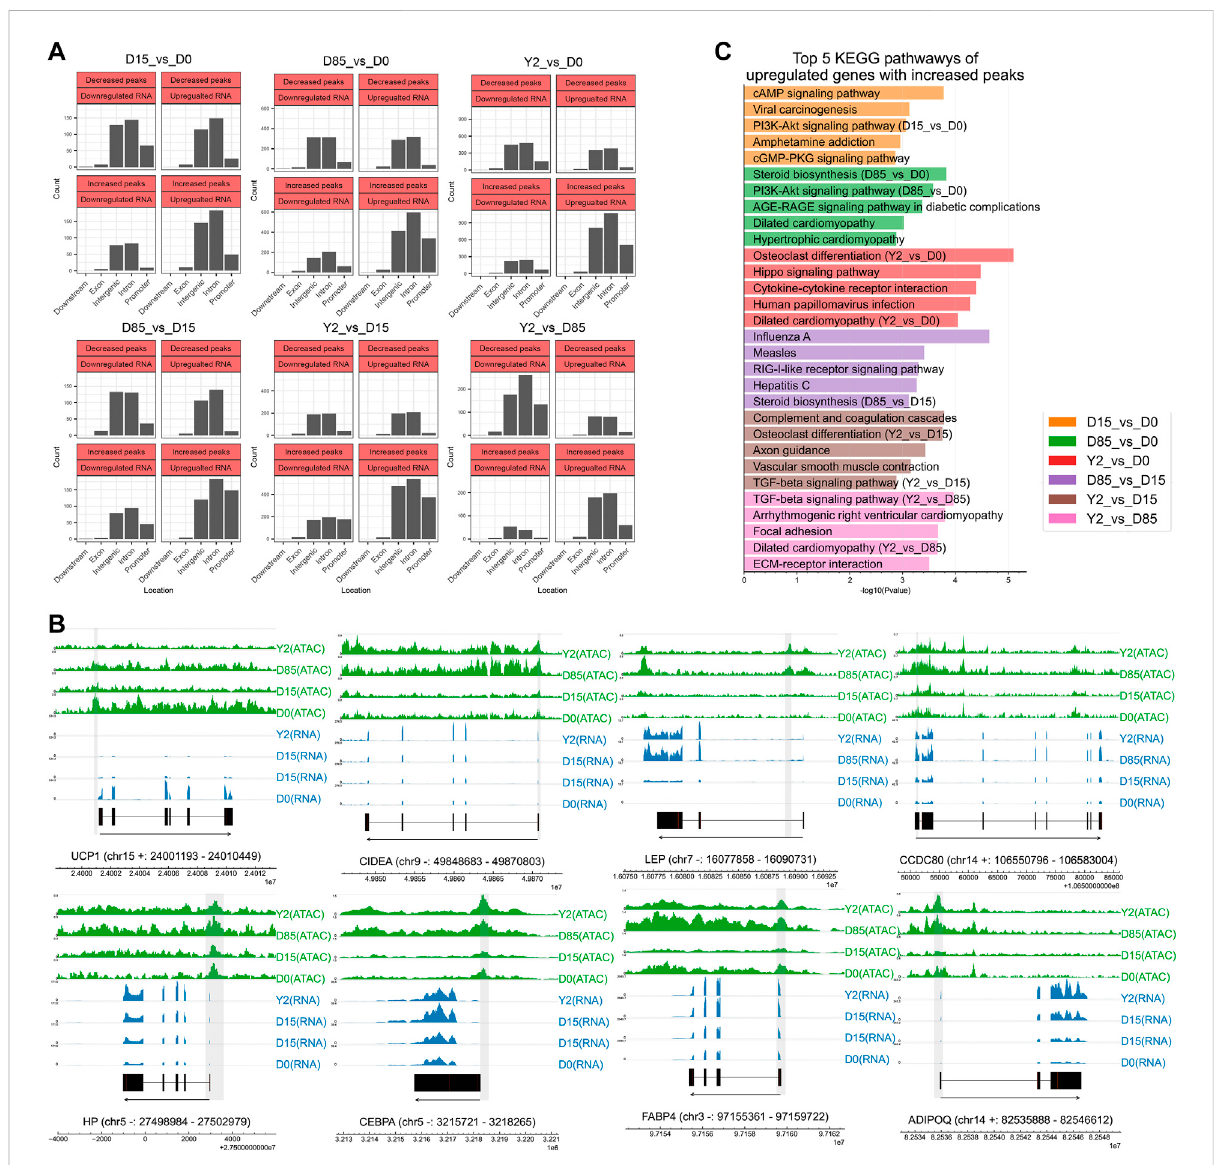
FIGURE 3 Combined analysis of ATAC-seq data and RNA-seq data. (A) Analysis of four types of relationship between chromatin accessibility and gene expressionbasedondifferentgenomicelements. (B) Tracksofkeyadiposegenes.TheblueandgreentracksshowingthereadscoverageofRNA-seq andATAC-seq.Geneexonsaremarkedinblack.Geneinformationismarkedby “ genename(chromosomestrand:start-end) ” .ThelocationsofDPs were shadowed in grey. (C) KEGG pathway analysis of upregulated genes with increased peaks. Genome-wide footprinting analysis revealed sequential regulation of potential TF